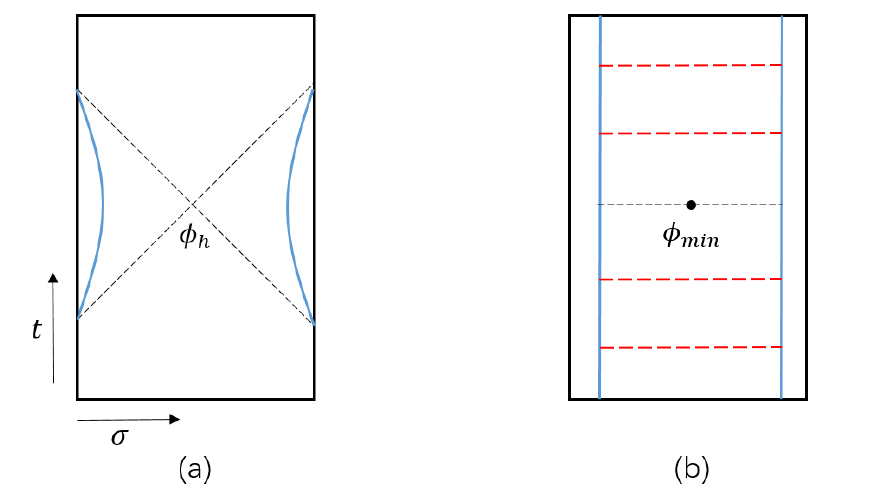
Figure 1 . (a) Without boundary couplings, the vacuum solution is a pair of decoupled black holes. The blue lines denote the boundary trajectories on the rigid AdS 2 space. For later purpose, we denote the dilaton (cid:12)eld on the bifurcation surface as (cid:30) h . (b) The ground state of the coupled model is an eternal traversable wormhole where the boundary trajectories propagate along the global time direction. The red dashed lines denote the couplings. On a constant time slice, the minimal value of the dilaton (cid:12)eld lies in the middle of the